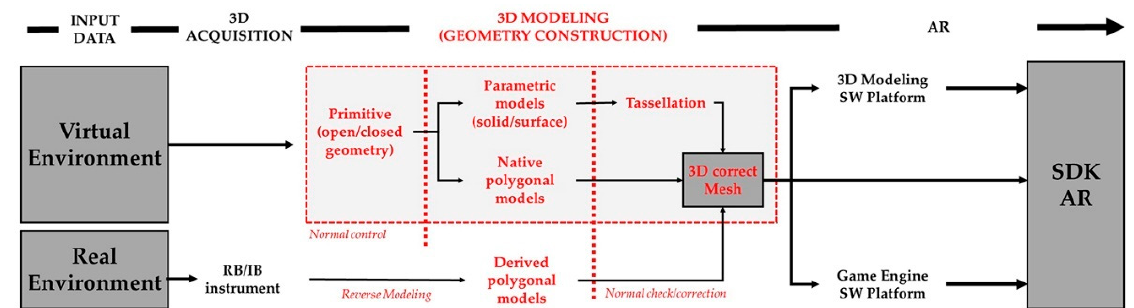
Figure 9. Diagram of 3D digital content creation for AR application. The 3D modeling passages and surface normal control are highlighted in red.